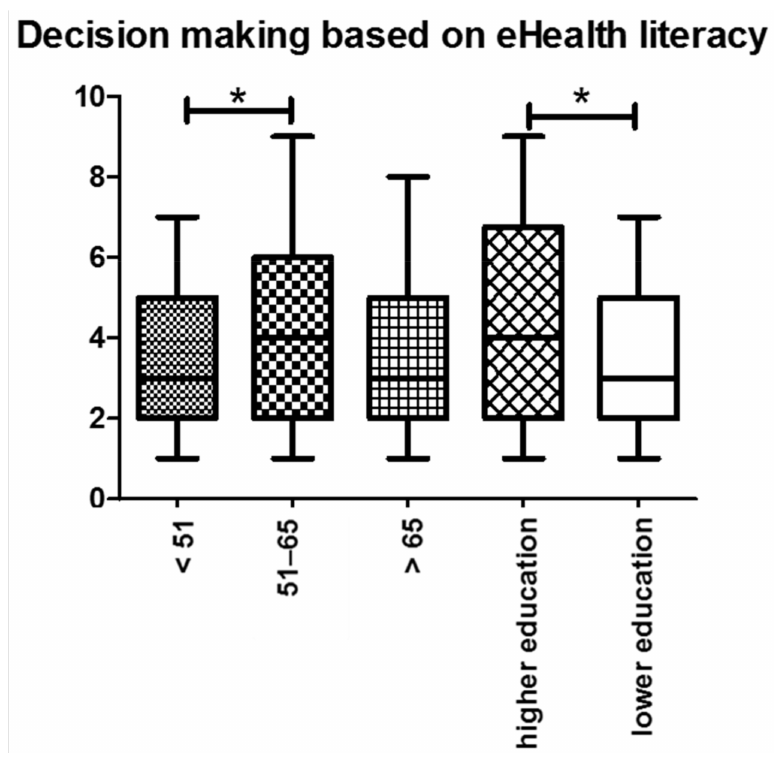
Figure 6. Decision making based on eHealth literacy: In general, older participants were more certain when making a decision based on health-related information from the Internet. Similarly, participants with higher education levels were more certain in their decision-making process. Abbreviations: * p <